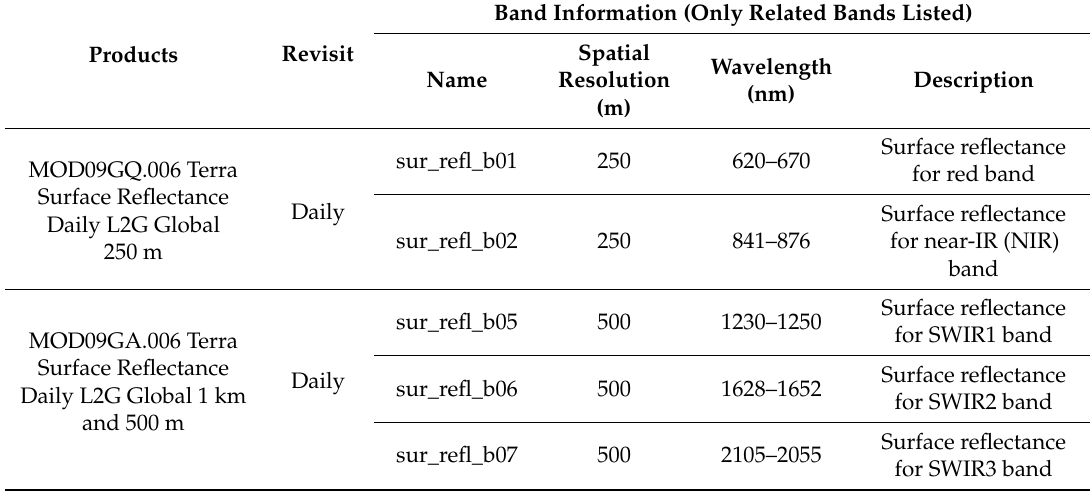
Table 1. Introduction of research datasets [43,44] .